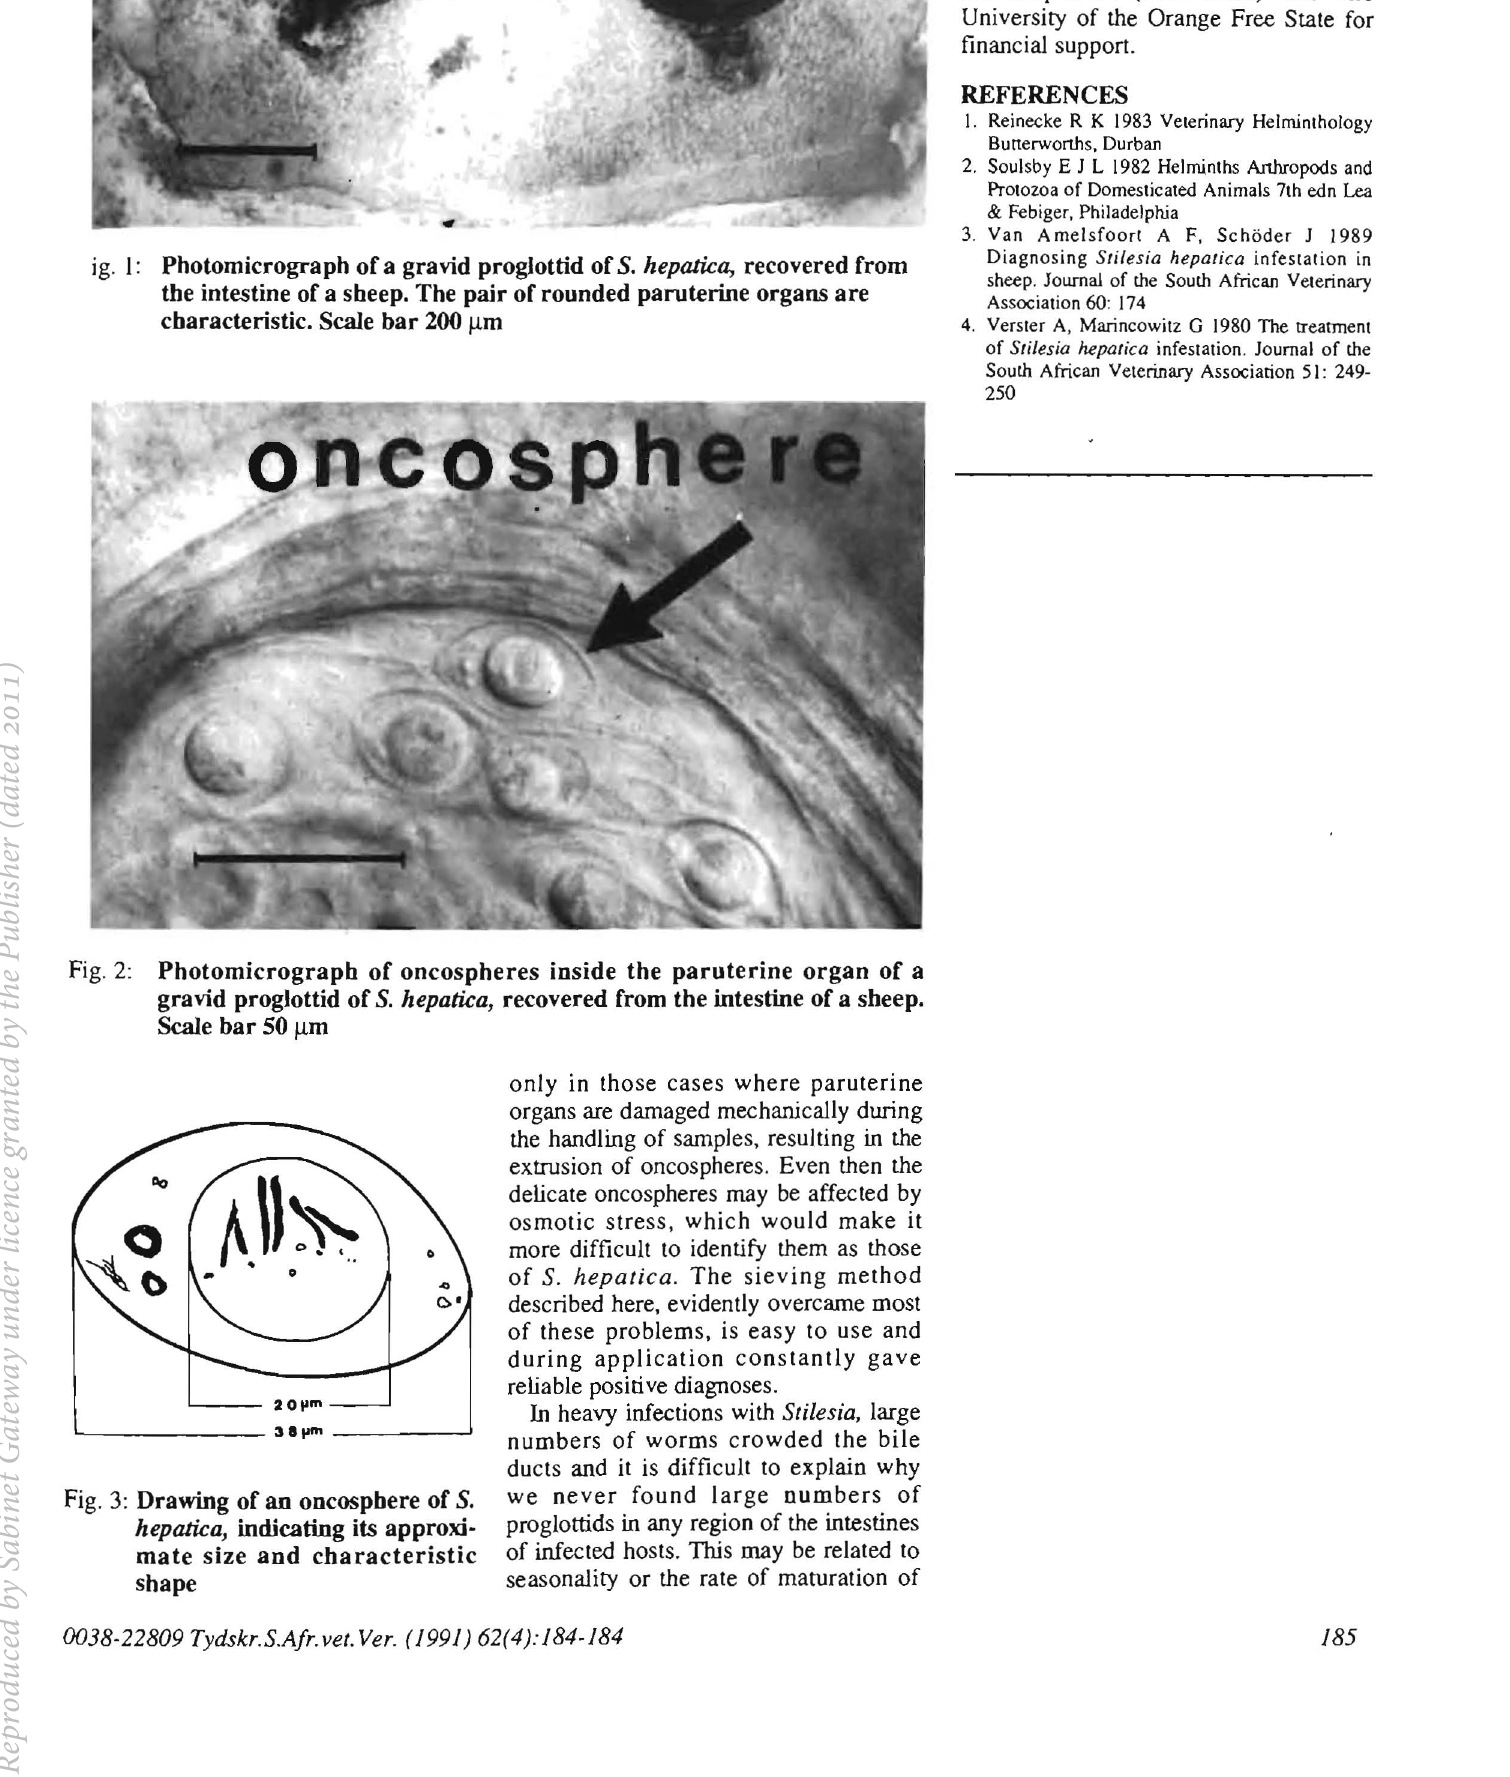
ig. I: Photomicrograph of a gravid proglottid of S. hepatica, recovered from the intestine of a sheep. The pair of rounded paruterine organs are cbaracteristic. Scale bar 200 ~m